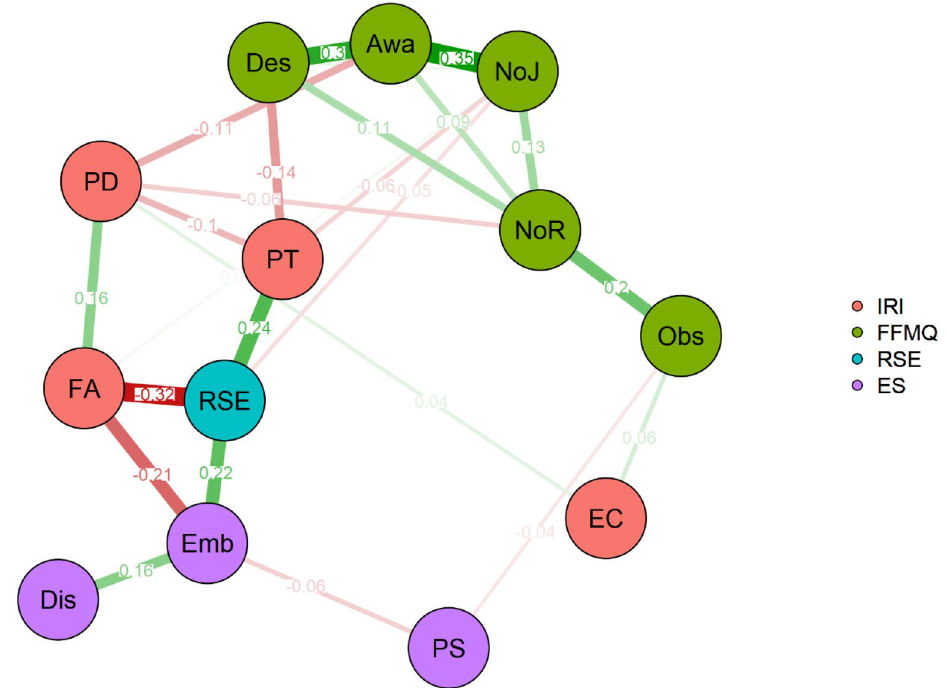
Figure 7. Network analysis results. Each node represents a different variable. The colour scheme helps to identify the nodes coming from different questionnaires. Edges show the association left between any two variables after conditioning on all other variables. Red edges identify negative relations. Green edges show positive relations. Edge labels report the exact value of the relation estimated by the GGM. The edge thickness and colour saturation is related to the edge value and helps in popping out the strongest relations. ES Embodiment Scale): Emb embodiment, Dis disembodiment, PS physical sensations. IRI (Interpersonal Reactivity Index): FA fantasy, EC empathic concerns, PD personal distress, PT perspective taking. FFMQ (Five Facet Mindfulness Questionnaire): Obs observe, NoR non-react, NoJ non-judge, Awa awareness, Des describe, RSE Rosenberg self-esteem